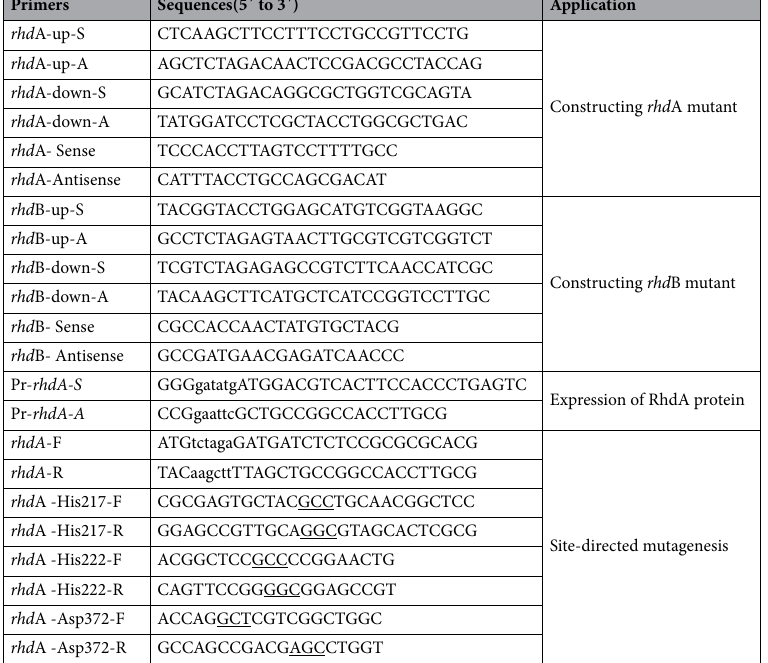
Table 2. Primers used by this research. The mutation site of rhd A is underlined and the mutation of nucleotide bases, all of which are translated to alanine